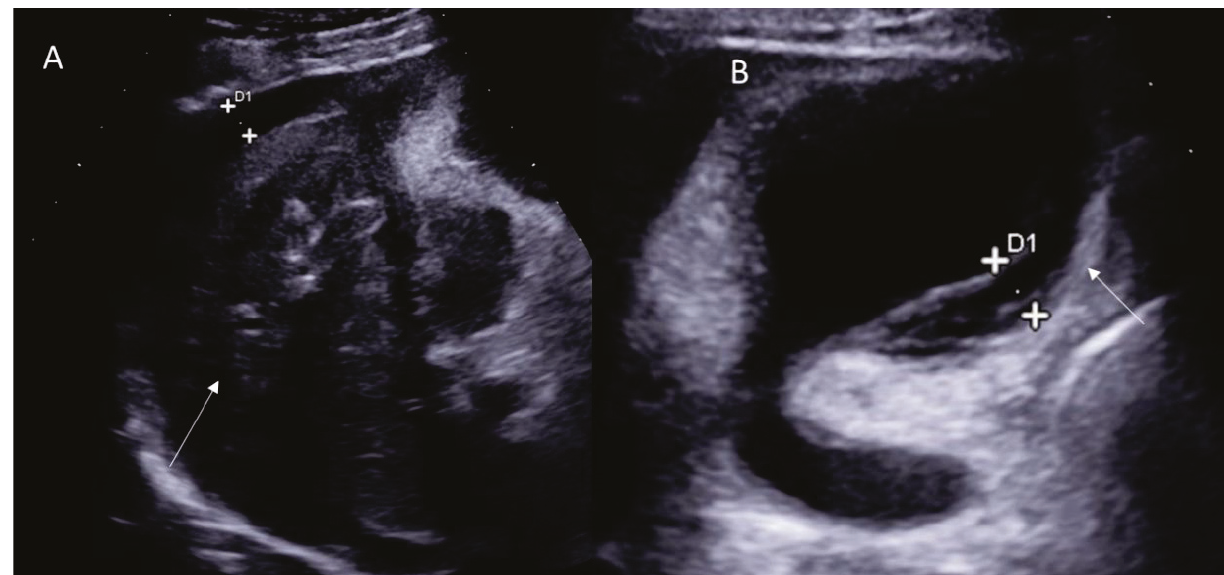
Figure 5. Woman 58 year at 1-week follow-up after MWA of liver metastasis. MRI assessment US assessment of RFA treated HCC on V segment (( A ); arrow). In ( B ) arrow shows cholecystitis.